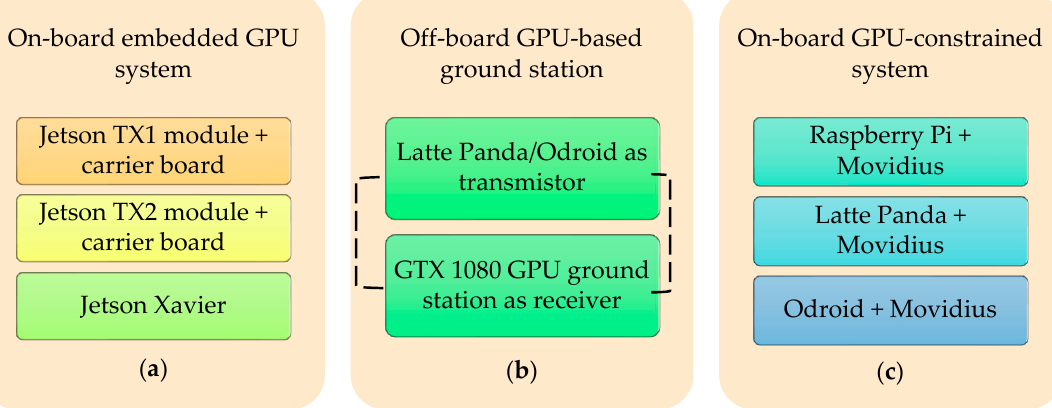
Figure 3. List of the embedded systems implemented inside the common drone structure. ( a ) On-board embedded GPU system; ( b ) off-board GPU-based ground station; ( c ) on-board GPU-constrained system.